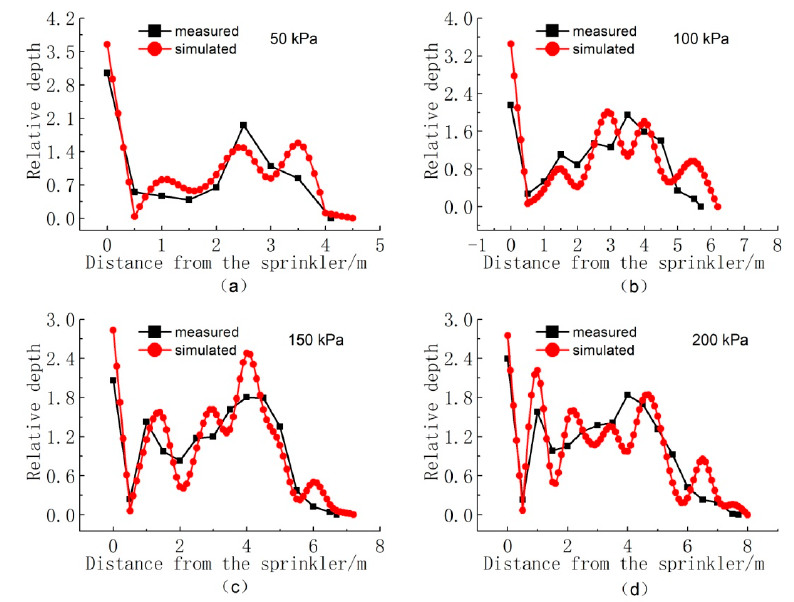
Figure 9. Measured and calculated relative water depths for the Nelson D3000 fixed spray-plate sprinkler (FSPS) in lateral motion with 1 m mounting height at different working pressures: ( a ) 50 kPa, ( b ) 100 kPa, ( c ) 150 kPa, and ( d ) 200 kPa.